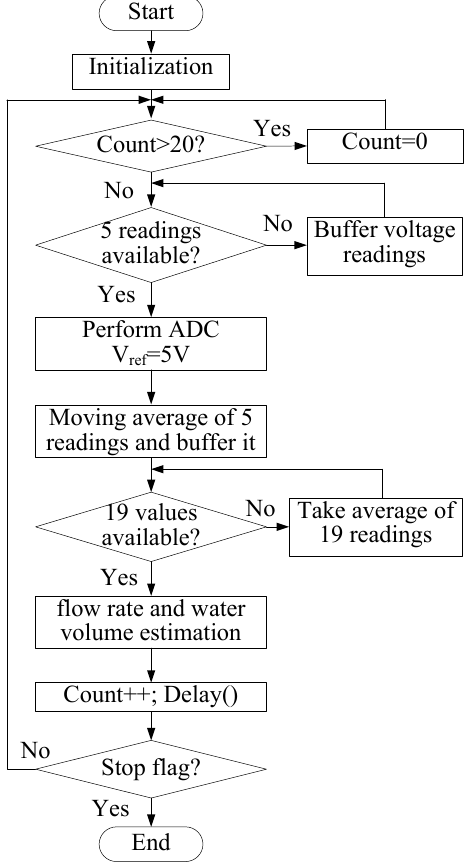
Figure 13. Smart meter algorithm